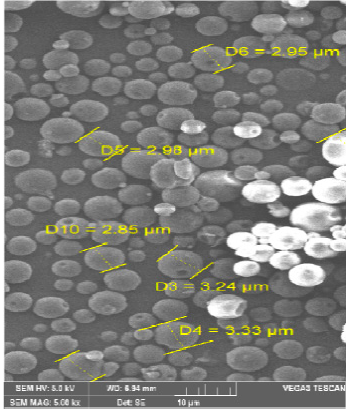
Figure 2. Surface morphology of the optimized formula of a MXF-loaded poly (lactic-co-glycolic acid) (PLGA) microsphere (MXF-PLGA-MS). (Magnification 5000×).